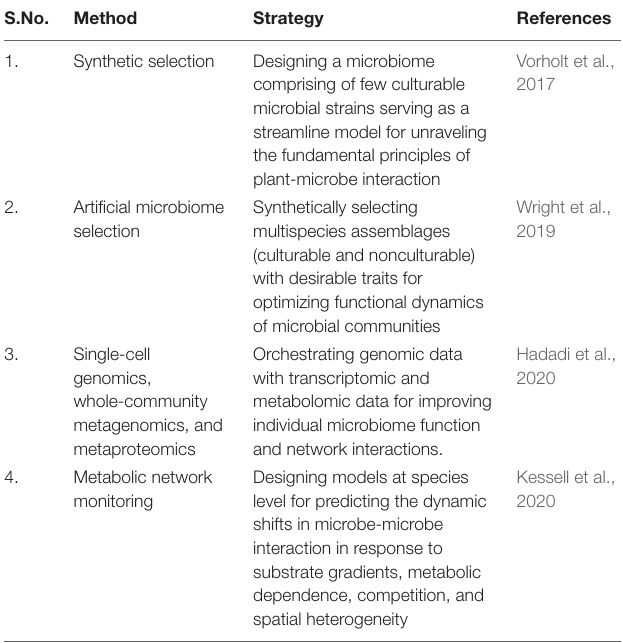
TABLE 3 | Methods adopted for plant based microbiome